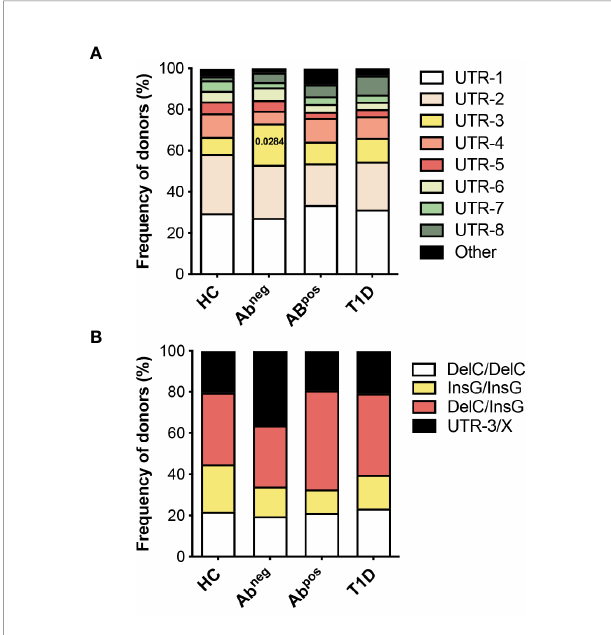
FIGURE 5 | HLA-G UTR-3 is more represented in Ab neg fi rst-degree relatives (FDRs). (A) Allele relative frequencies based on the analysis of nine polymorphic sites present in the 3 ′ UTR of HLA-G locus in healthy donors (HC; n = 78), fi rst- degree relatives of type 1 diabetes (T1D) patients without (Ab neg , n = 97) or with (Ab pos , n = 52) autoantibodies, and T1D patients (T1D, n = 43) are shown. (B) Genotype relative frequencies for 14-bp Ins/Del and +3142 G/C polymorphisms present in the 3 ′ UTR of HLA-G locus in the indicated cohorts of donors are shown. The logistic mixed-effects models were employed for comparing the relative frequency of the single haplotypes or genotypes of all groups vs . HCs, as described in the Materials and Methods . Numbers indicate statistically signi fi cant Bonferroni ’ s adjusted p-values. The p-values of all comparisons are reported in Supplementary Table S5